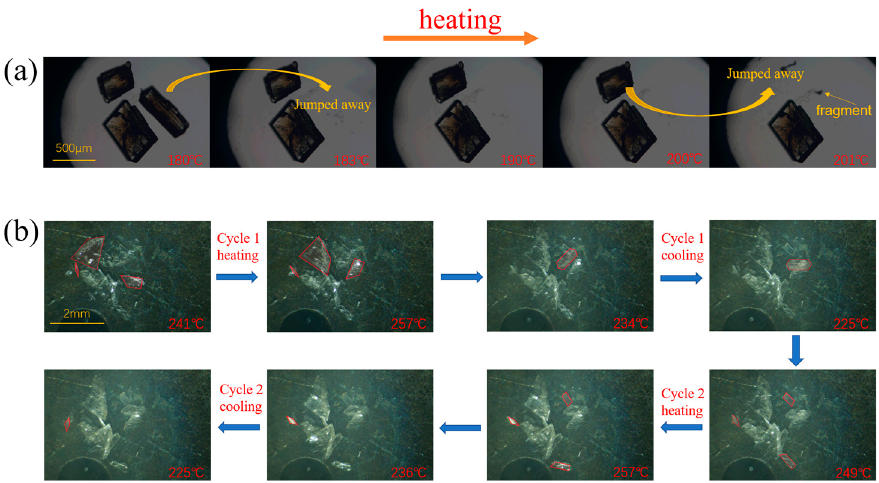
Figure 1. ( a ) Heating jump of TMP-25HBA (TMP: Trimethoprim; 25HBA: 2,5-dihydroxybenzoic acid) with heating rate of 10 °C/min monitored using the microscope; ( b ) thermal stimulation of TMP-OA (TMP: Trimethoprim; OA: Orotic acid) under two heating–cooling cycles between 190 °C and 265 °C.